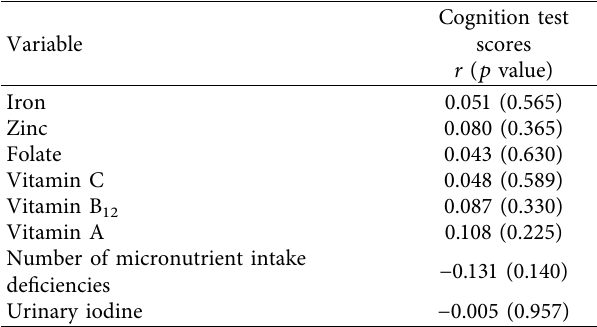
Partial correlation analysis was performed between micronutrient intake and cognition test scores. Correlation is significant at p value ≤ 0.05 (2- tailed). Controlling variables: age and